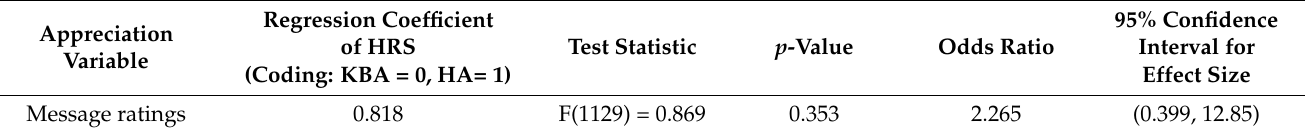
Table 3. Comparison between the two HRS groups of their results for main effects on the appreciation variable for non-dropouts over the 0–180 days’ time period.